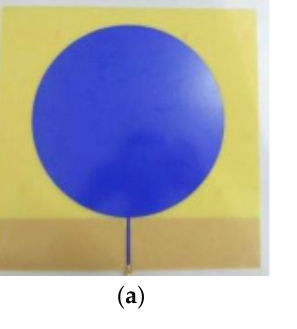
Figure 17. Microstrip antennas: ( a ) the circularly printed monopole antenna studied in [118], ( b ) the bio-inspired antenna based on the Inga Marginata studied in [119], ( c ) the UWB-printed antenna with a modified U-shaped proposed and studied in [120], and ( d ) the circular-shaped microstrip patch antenna studied in